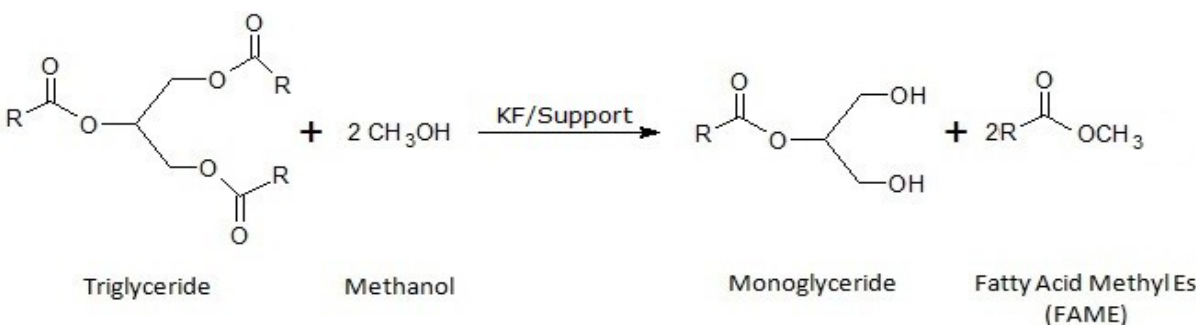
Figure 1. Representative scheme of the production of Ecodiesel, a biofuel, by partial methanolysis of sunflower